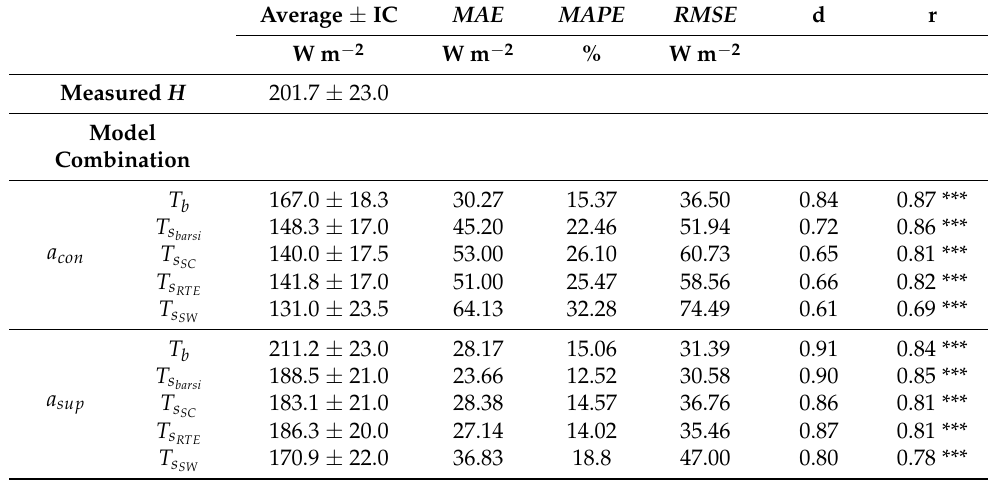
Table 8. Average ( ± 95% confidence interval) of the measured sensible heat flux ( H ; W m − 2 ) in the flux towers, and the average ( ± 95% confidence interval), mean absolute error ( MAE ), mean absolute percent error ( MAPE ), root mean square error ( RMSE ), Willmott coefficient (d), and Pearson correla- tion coefficient (r) of the estimated sensible heat flux using the conventional ( a con ) and parameterized ( a sup ) surface albedo models combined with brightness temperature ( T b ) and surface temperature corrected by the Barsi model ( T s ), the single-channel model ( T s ), the radiative transfer equation SC barsi model ( T s ), and the split-window model ( T s ). Values with (***) indicate p -value < 0.001. RTE SW Average ± IC